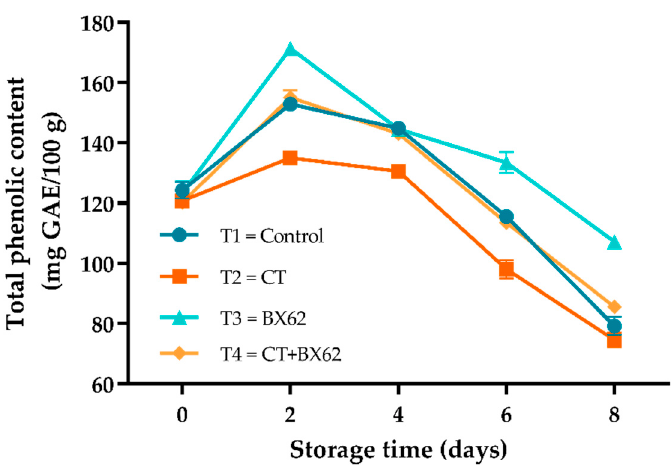
Figure 4. Changes in TPC for the control apples ( ● ), chitosan-treated apples ( ■ ), L. plantarum BX62- treated apples ( ▲ ), and chitosan in combination with L. plantarum BX62-treated apples ( ◆ ) after being stored at 4 °C for 8 days. Each data point is the mean of three replicate samples.